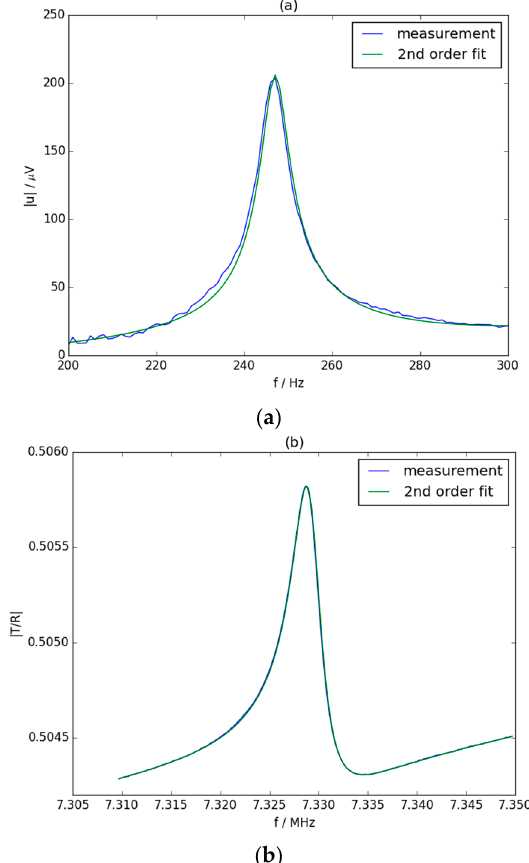
Figure 3. Measured resonance spectra of the ( a ) low frequency electrodynamic transducer and ( b ) the high frequency quartz resonator with fitted second order system